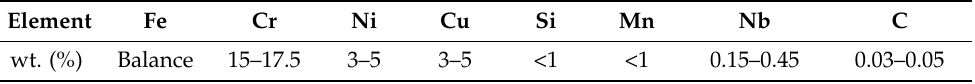
Table 1. Chemical composition (Wt. %) of the 17-4PH stainless steel powder, adapted from [28,29]. Element